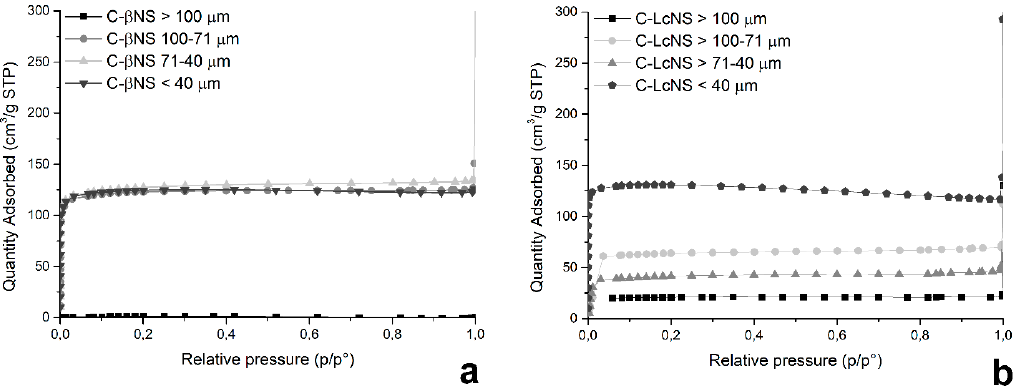
Figure 4. Representative sphere formation scheme; the arrow indicates the direction of contraction of the part still soft towards the solid outer shell.